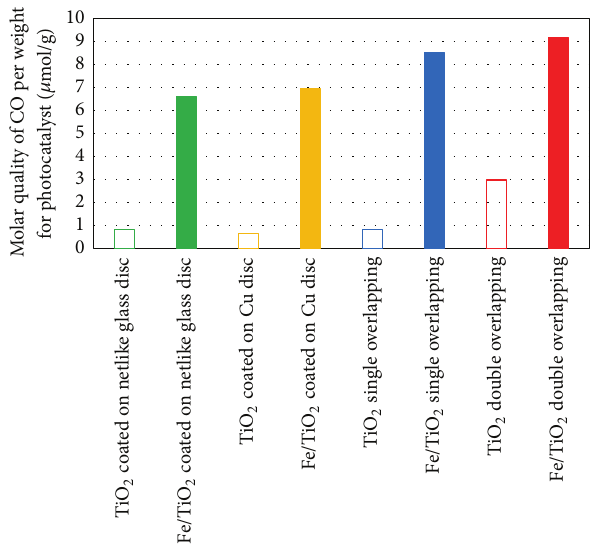
Figure 16: Comparison of CO 2 reduction performances per weight of photocatalyst under the illumination condition without UV light.